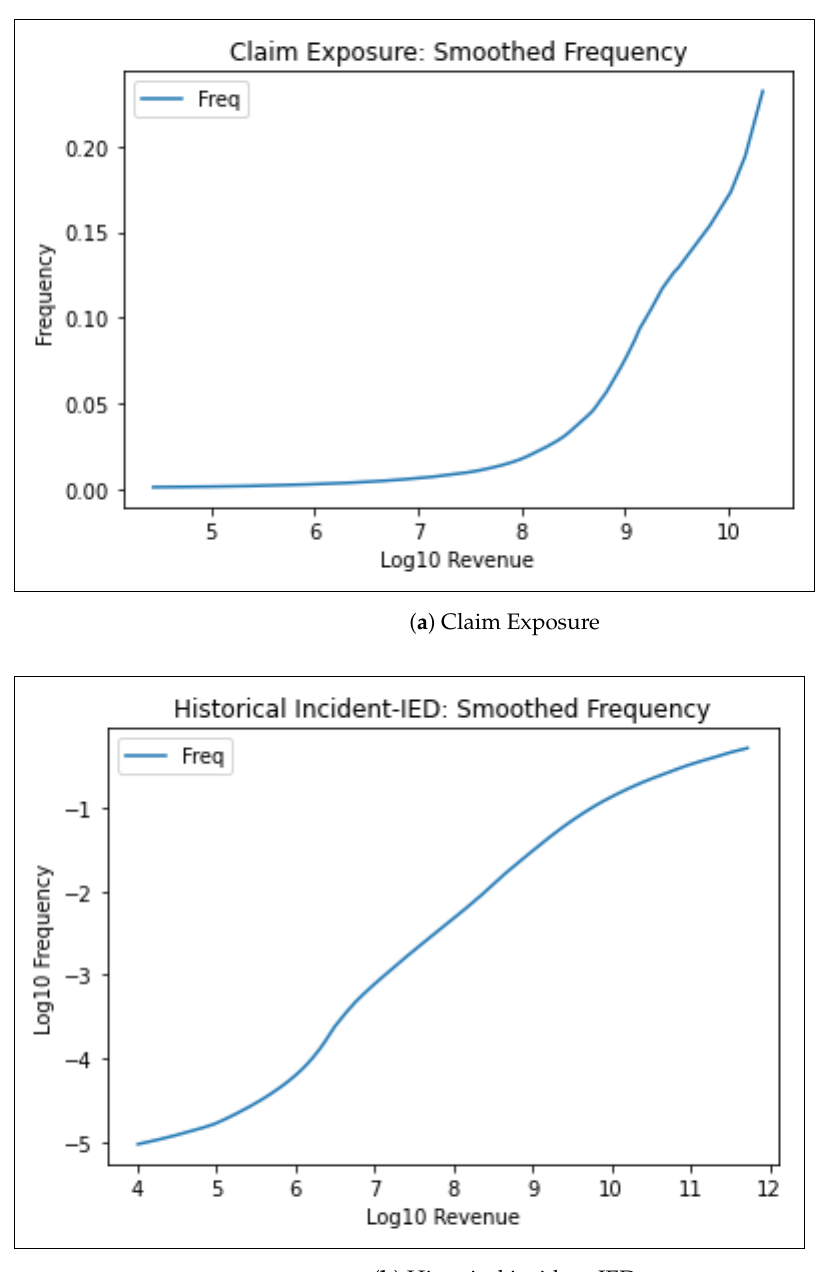
Figure 1. Smoothed Frequency